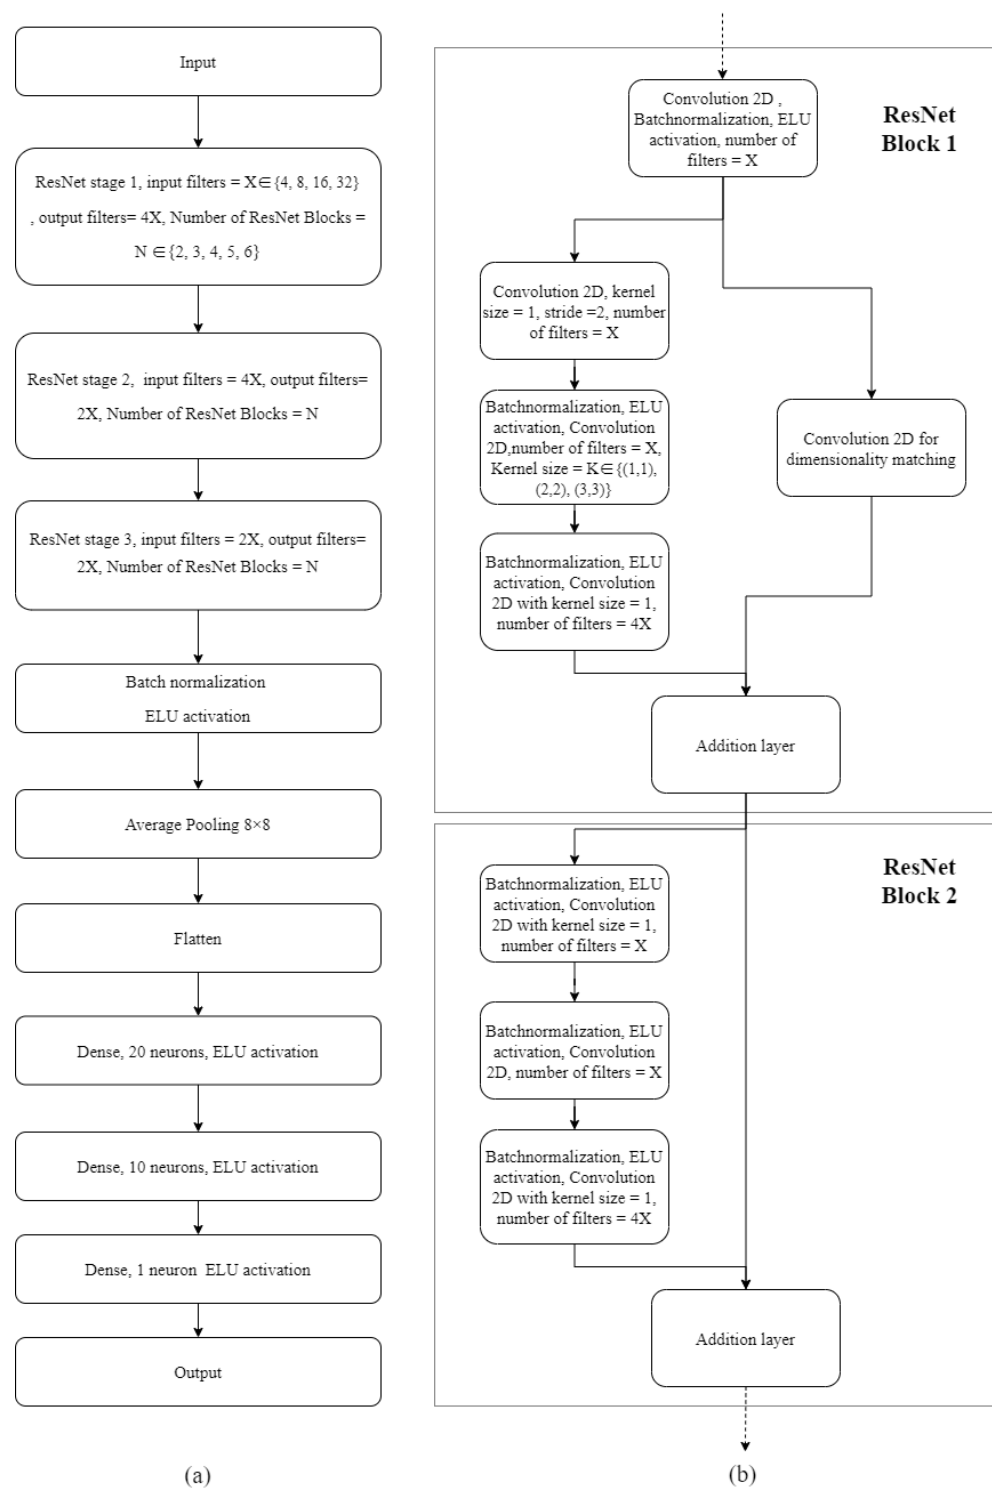
Figure 3. Residual neural network (ResNet) structural configuration. ( a ) is the overall residual neural network configuration which consists of three ResNet stages, fully connected layers, and dropout layers. The ResNet stage consists of multiple ResNet blocks; ( b ) is the network configuration for the ResNet stage 1, which consists of a certain number of ResNet blocks; stage 2 and stage 3 consist of multiple blocks as shown in ResNet block 2. Batch size ∈ {16, 32, 64} and training iterations ∈ {100, 150, 200} were also included in the hyperparameter optimization.